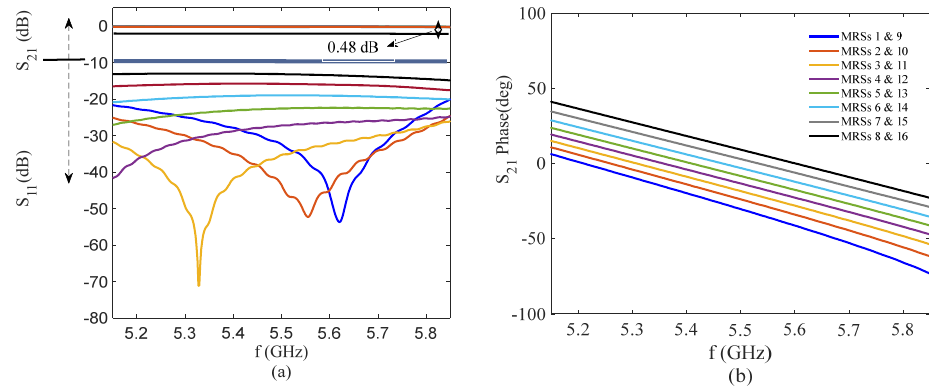
Figure 4. Parametric study of particle activation in MRSs along the symmetrical stub transmission lines. ( a ) Reflection coefficient, insertion loss, and ( b ) phase response of the unit cell P-CRLH phase shifter.